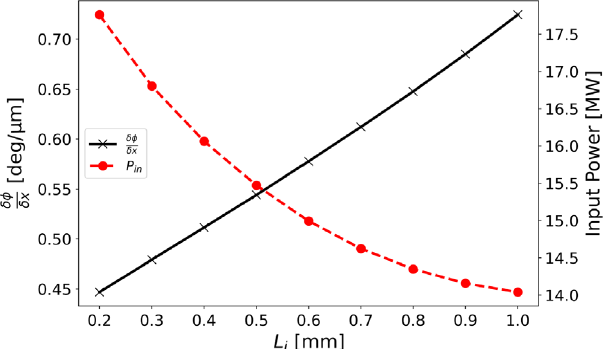
FIG. 13. Accumulated phase advance error and power needed to reach 12.75 MV of integrated voltage for a 2 π = 3 , 30-cm structure, as a function of the iris thickness for the disk-loaded simple